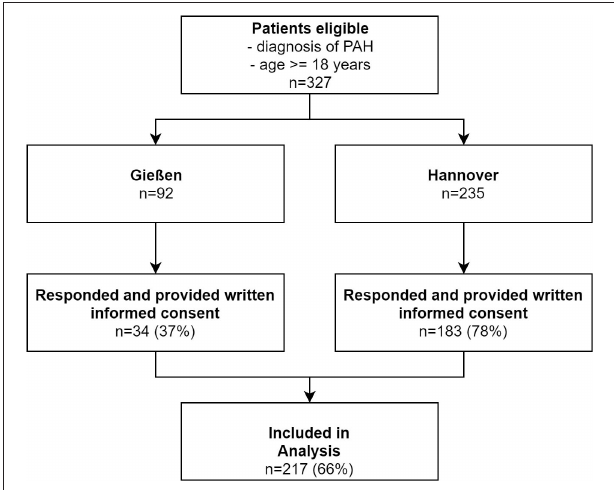
FIGURE 1 | Flowchart of patient inclusion. PAH, pulmonary arterial